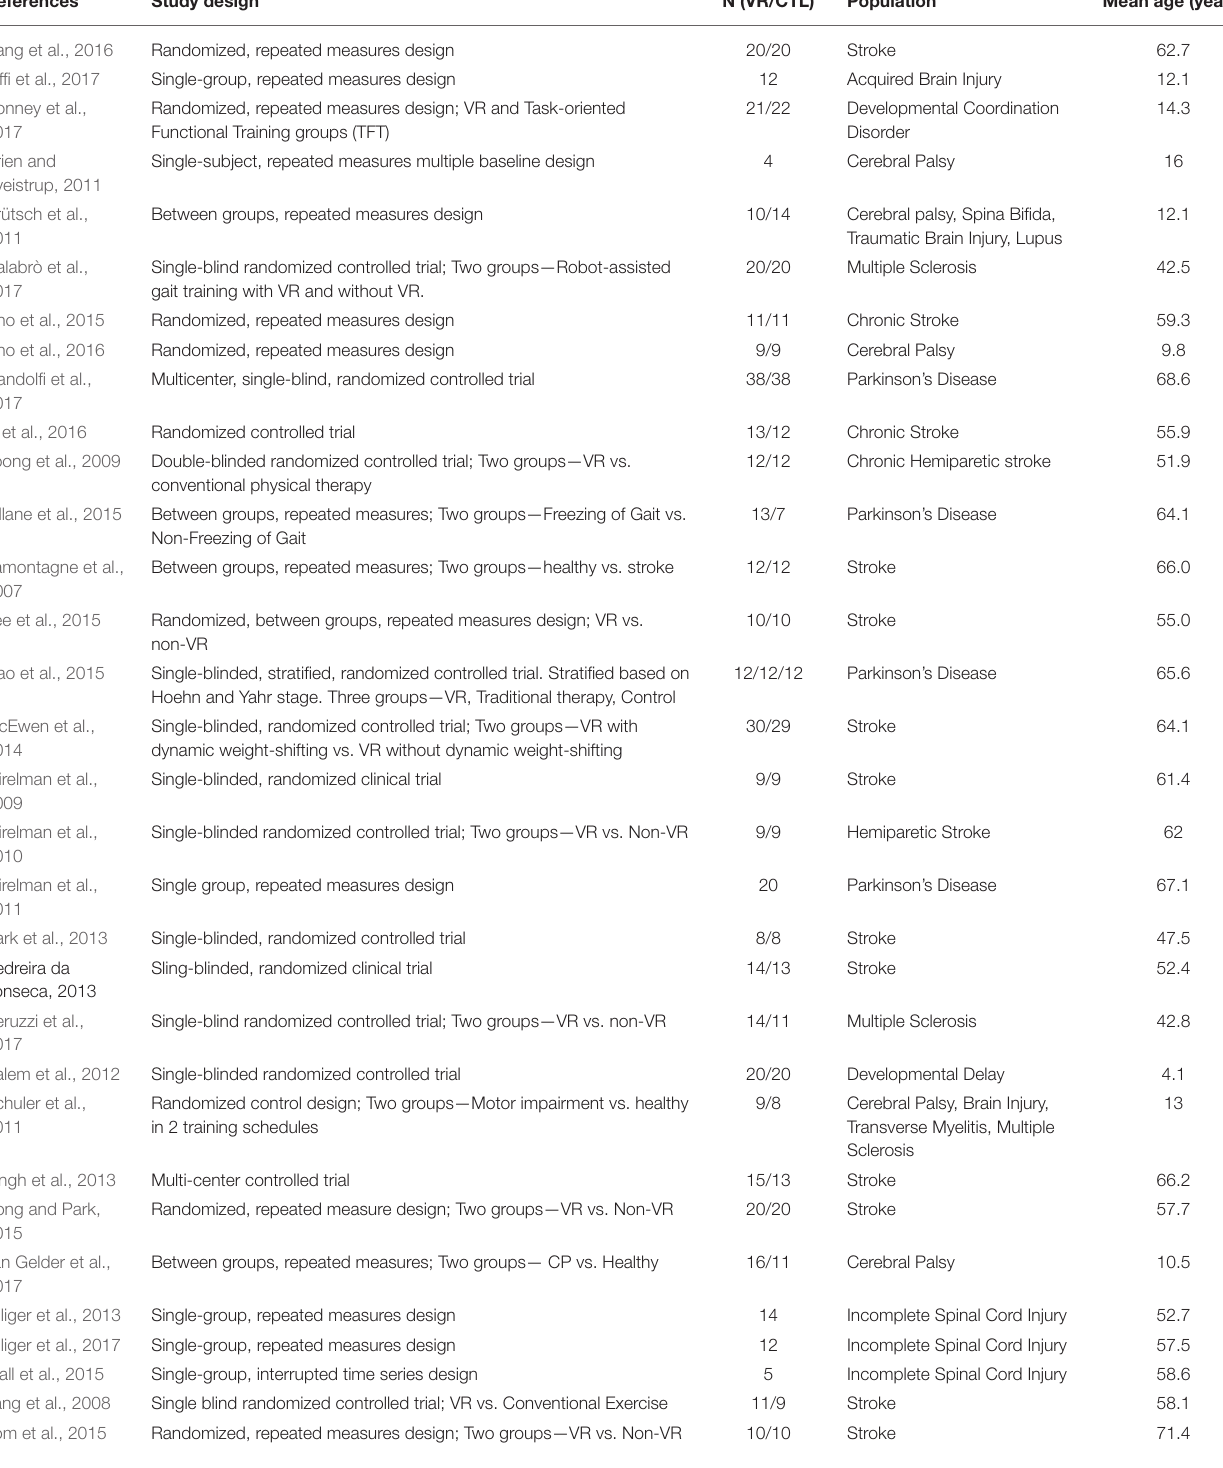
TABLE 1 | Summary of included articles investigating virtual reality interventions to improve motor performance in neurologic